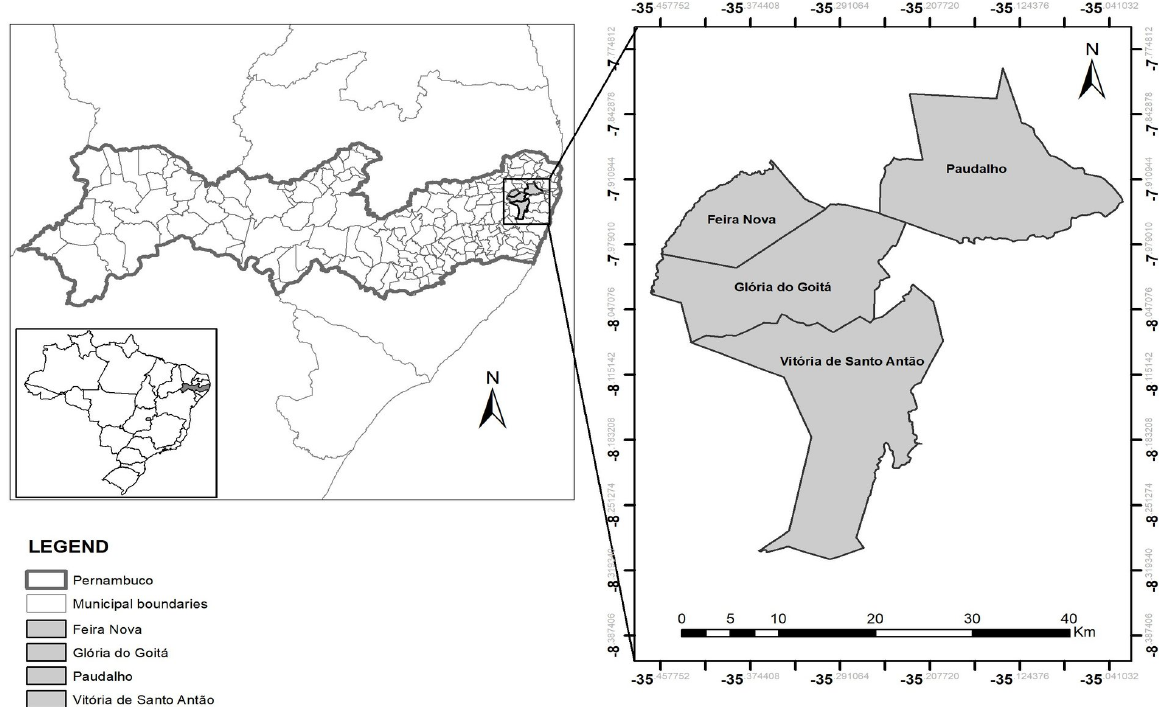
Figure 1. Map of Pernambuco highlighting municipalities of Feira Nova, Paudalho, Glória de Goitá and Vitória de Santo